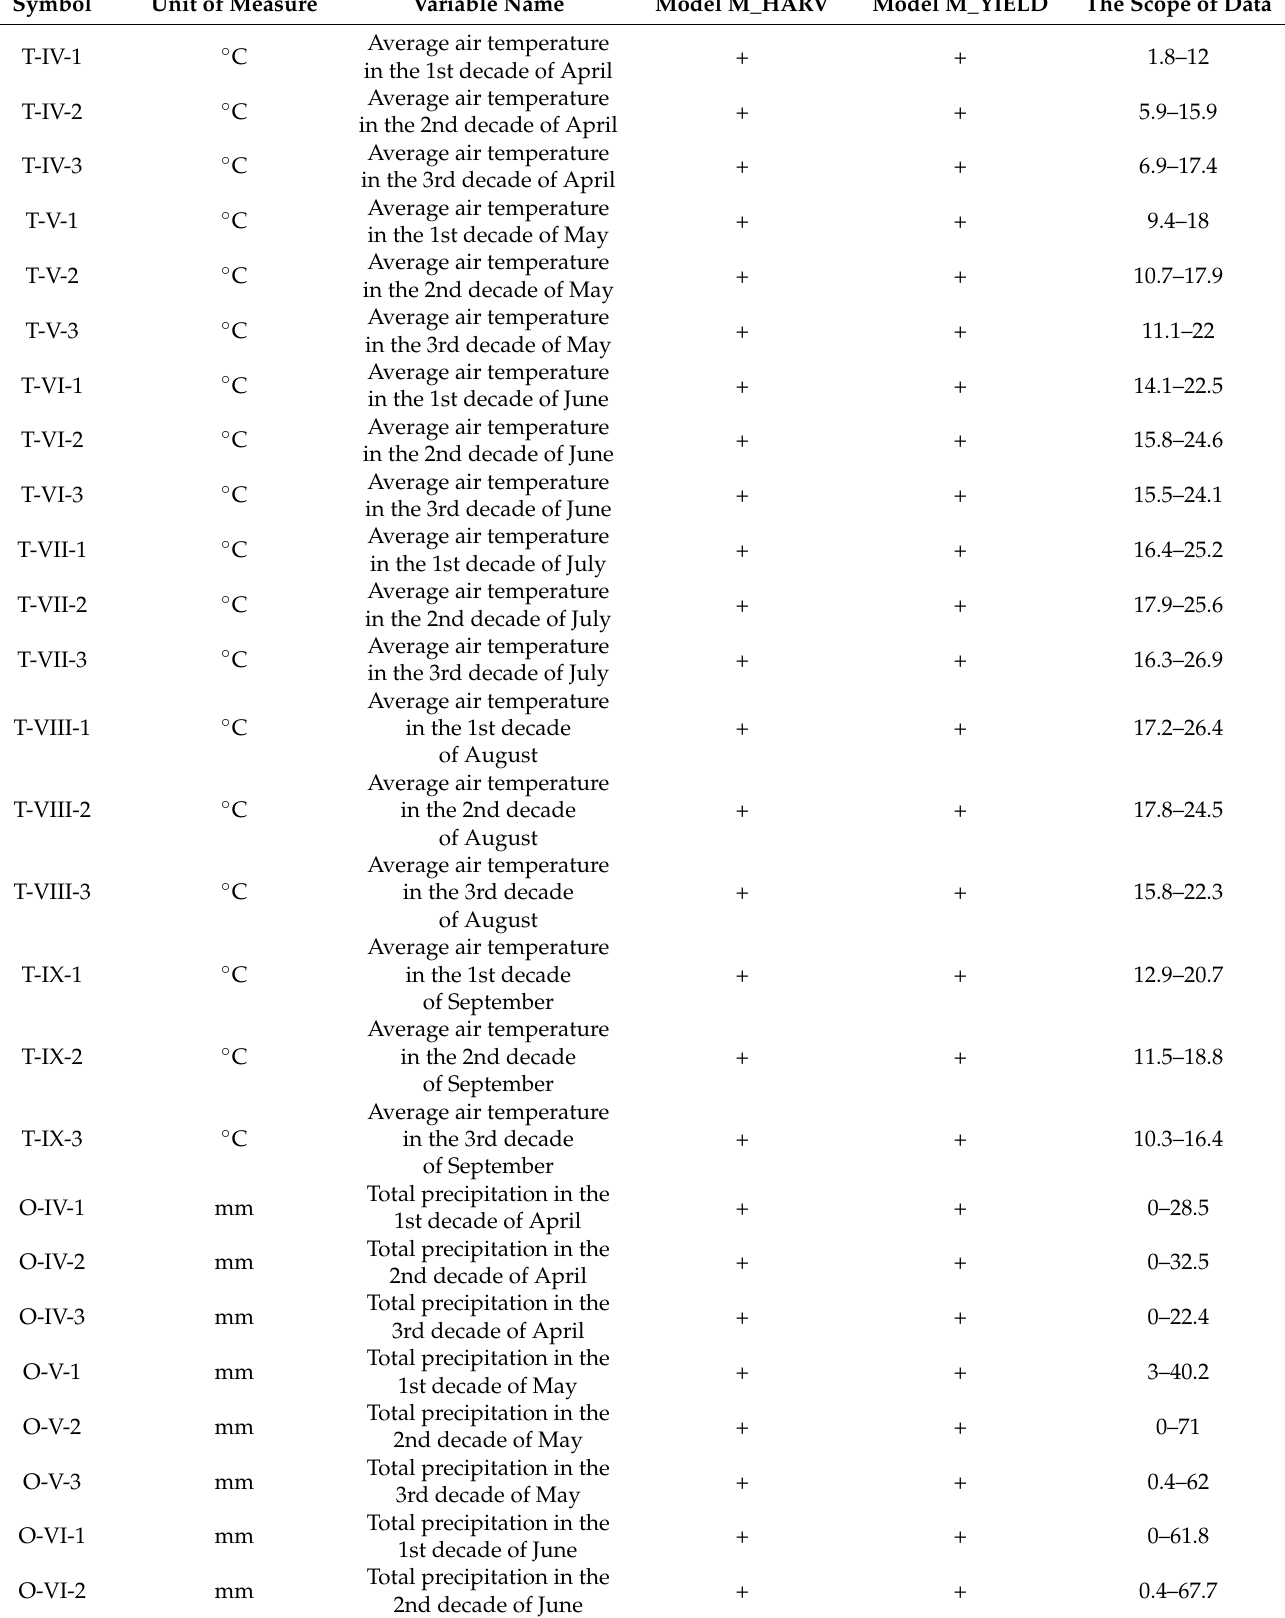
Table 1. The neural models’ data